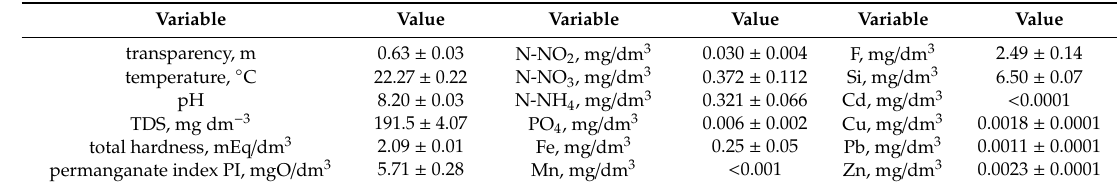
Table 1. Average physico-chemical and toxicological characteristics of Borovoe Lake, 2019 (mean with standard